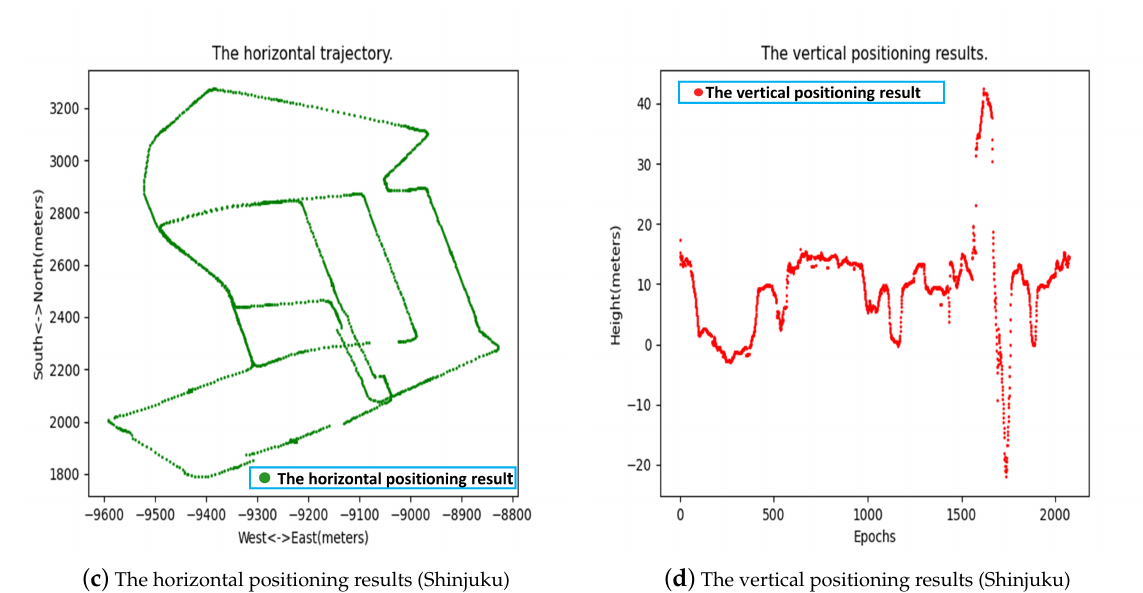
Figure 5. The solution